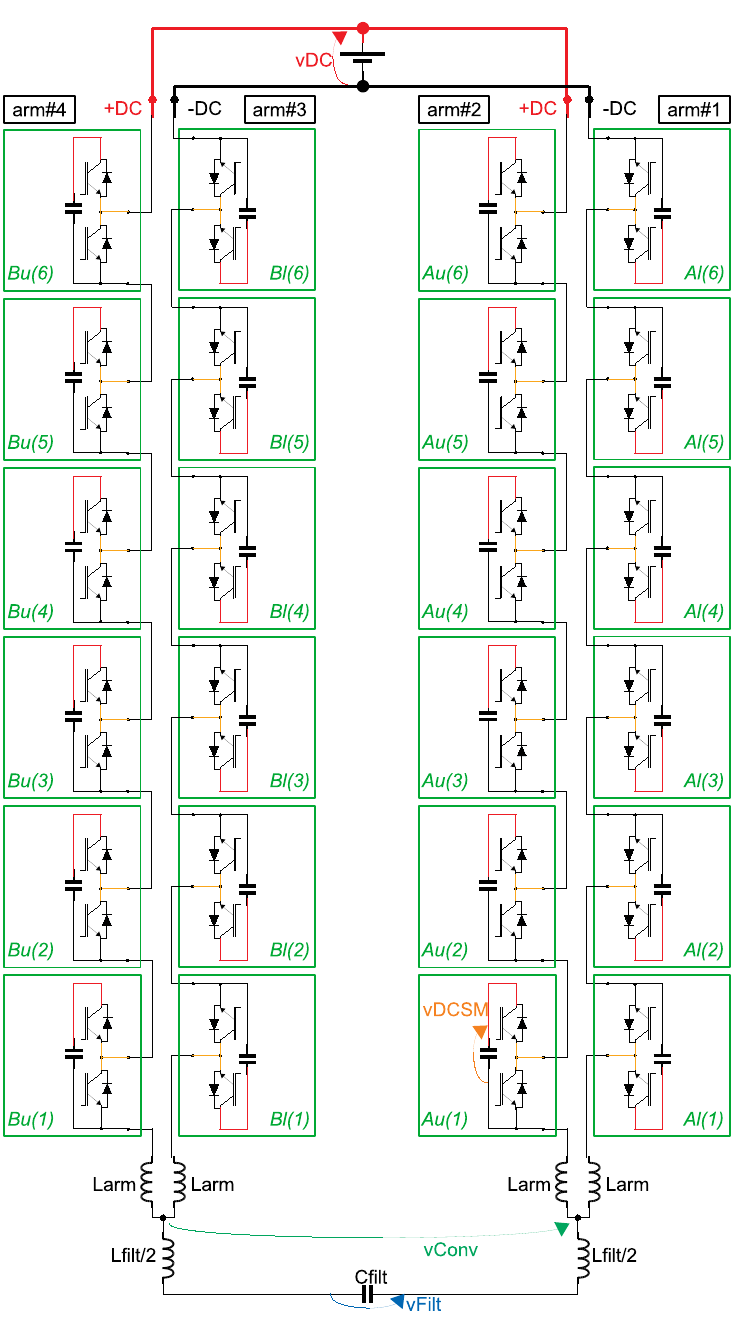
Figure 5. Schematics of the Modular Multilevel Converter (MMC) topology (bi-phase, 4 arms, N = 6